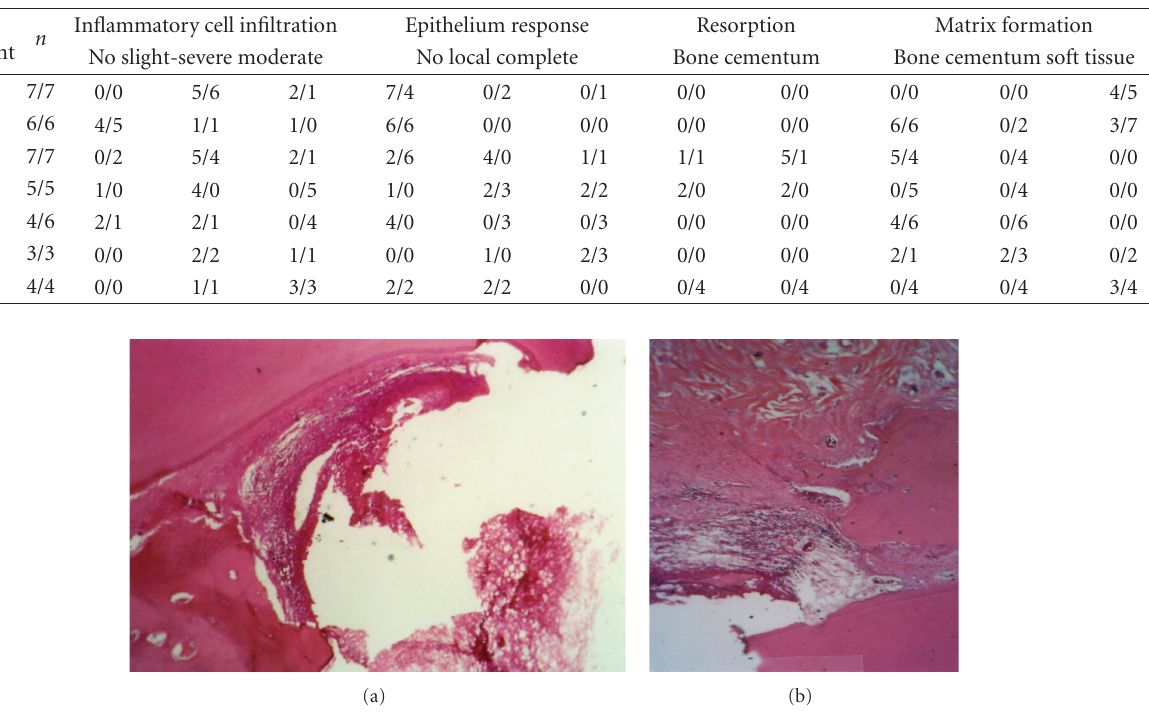
Figure 1: Periodontal tissue response in the dog following a 3- (a) or 8- (b) week application of IRM (control treatment). Note the moderate inflammatory cell infiltration and the superficial necrotic zone. New bone formation and a site of root resorption can be also seen after 8 weeks (magnification × 100).